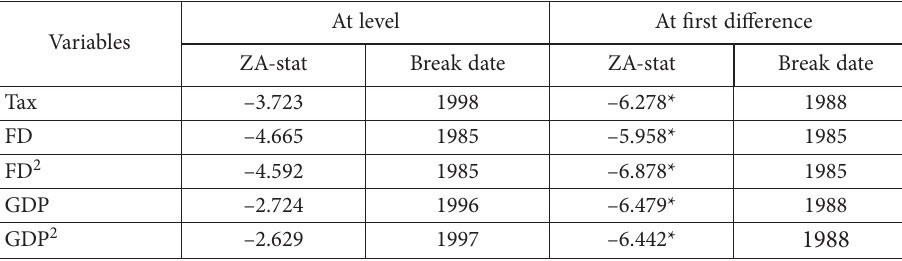
Table 3. Results of unit root test